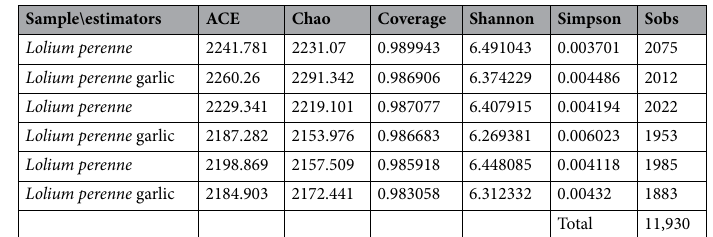
Table 4. Bacterial diversity and richness in soil of single plant and interplant ryegrass with garlic Cluster distance (0.03).